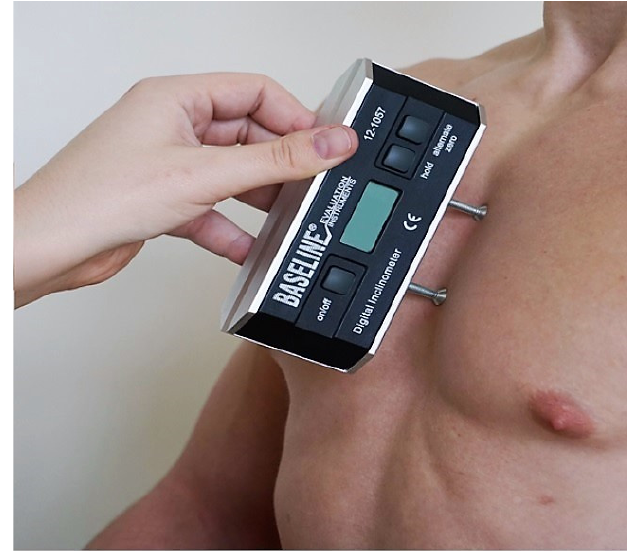
Figure 1. Measurement of the angle of the body of the sternum.